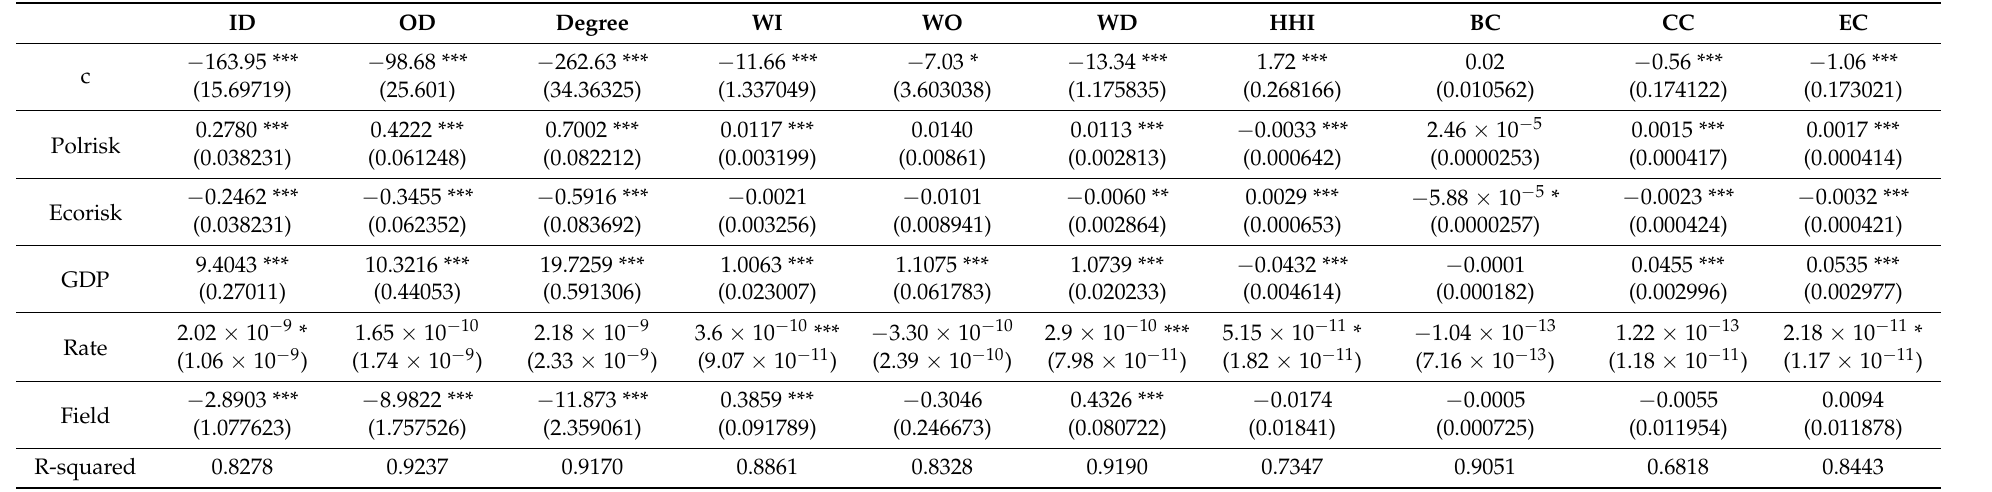
Table 1. The regression results of the country risks to trade